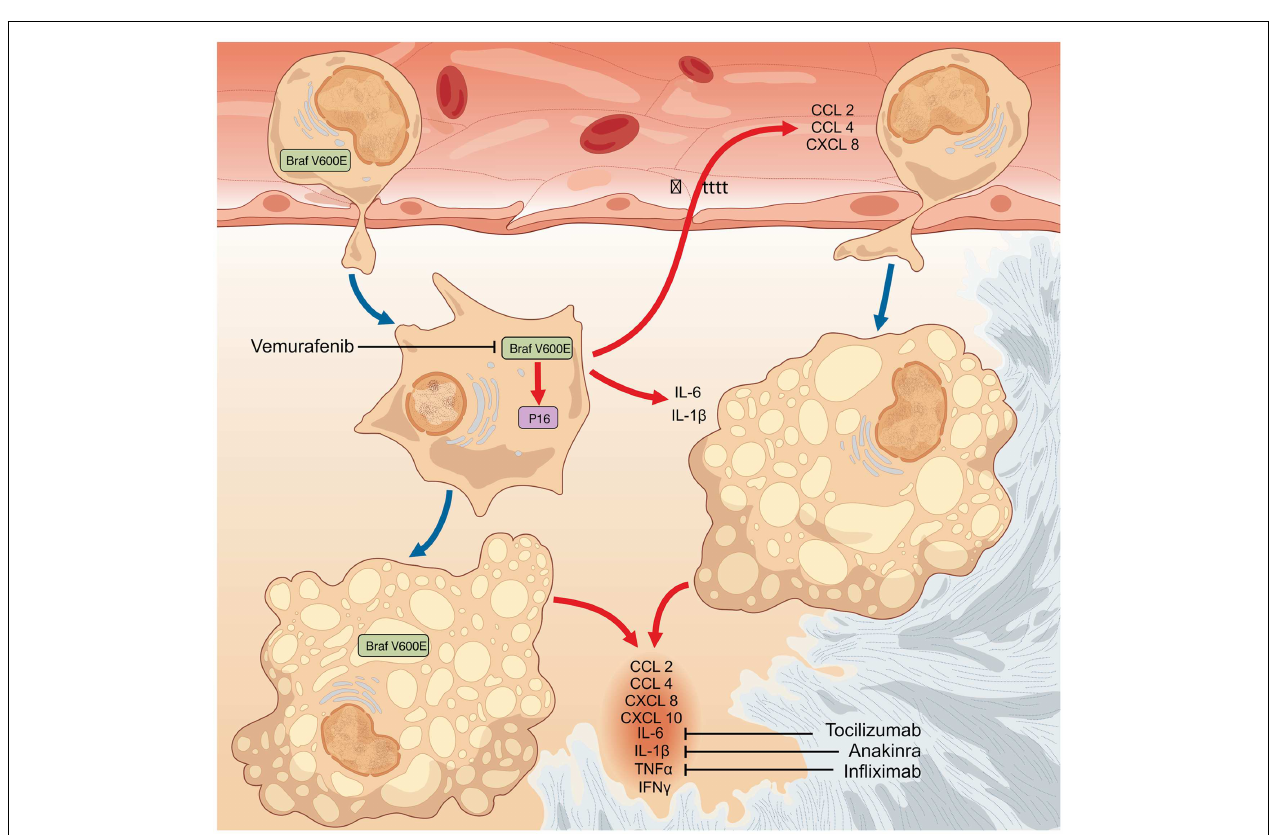
CCL4, CXCL8, CXCL10, IL-1 β , IL-6,TNF α , and IFN γ ).The so formed inflammatory milieu exerts autocrine and paracrine effects responsible for the recruitment of circulating wild-type inflammatory cells to lesion sites, and for the induction and maintenance of the senescent phenotype in both mutated and bystander infiltrating cells. Cytokine-blocking agents interfere with the inflammatory effects downstream BRAF V600E and exert moderate efficacy in the treatment of ECD, but are ultimately of no cure for the disease. Conversely, therapy with the selective BRAF V600E inhibitor vemurafenib might dampen all the pathogenetic mechanisms of